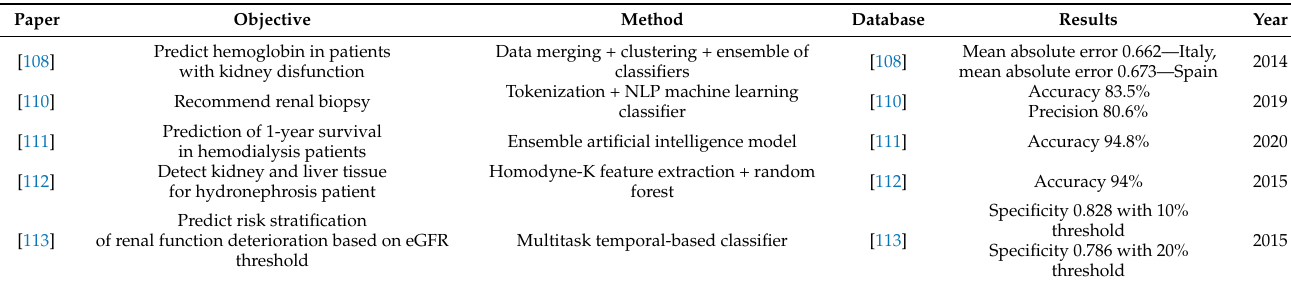
Table 7. Other renal diseases